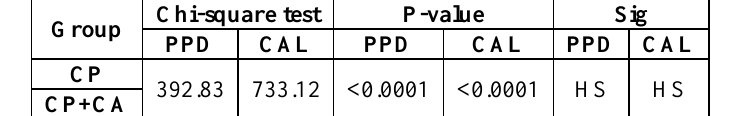
Table 3:Comparison between study groups according to PPD and CAL Scores